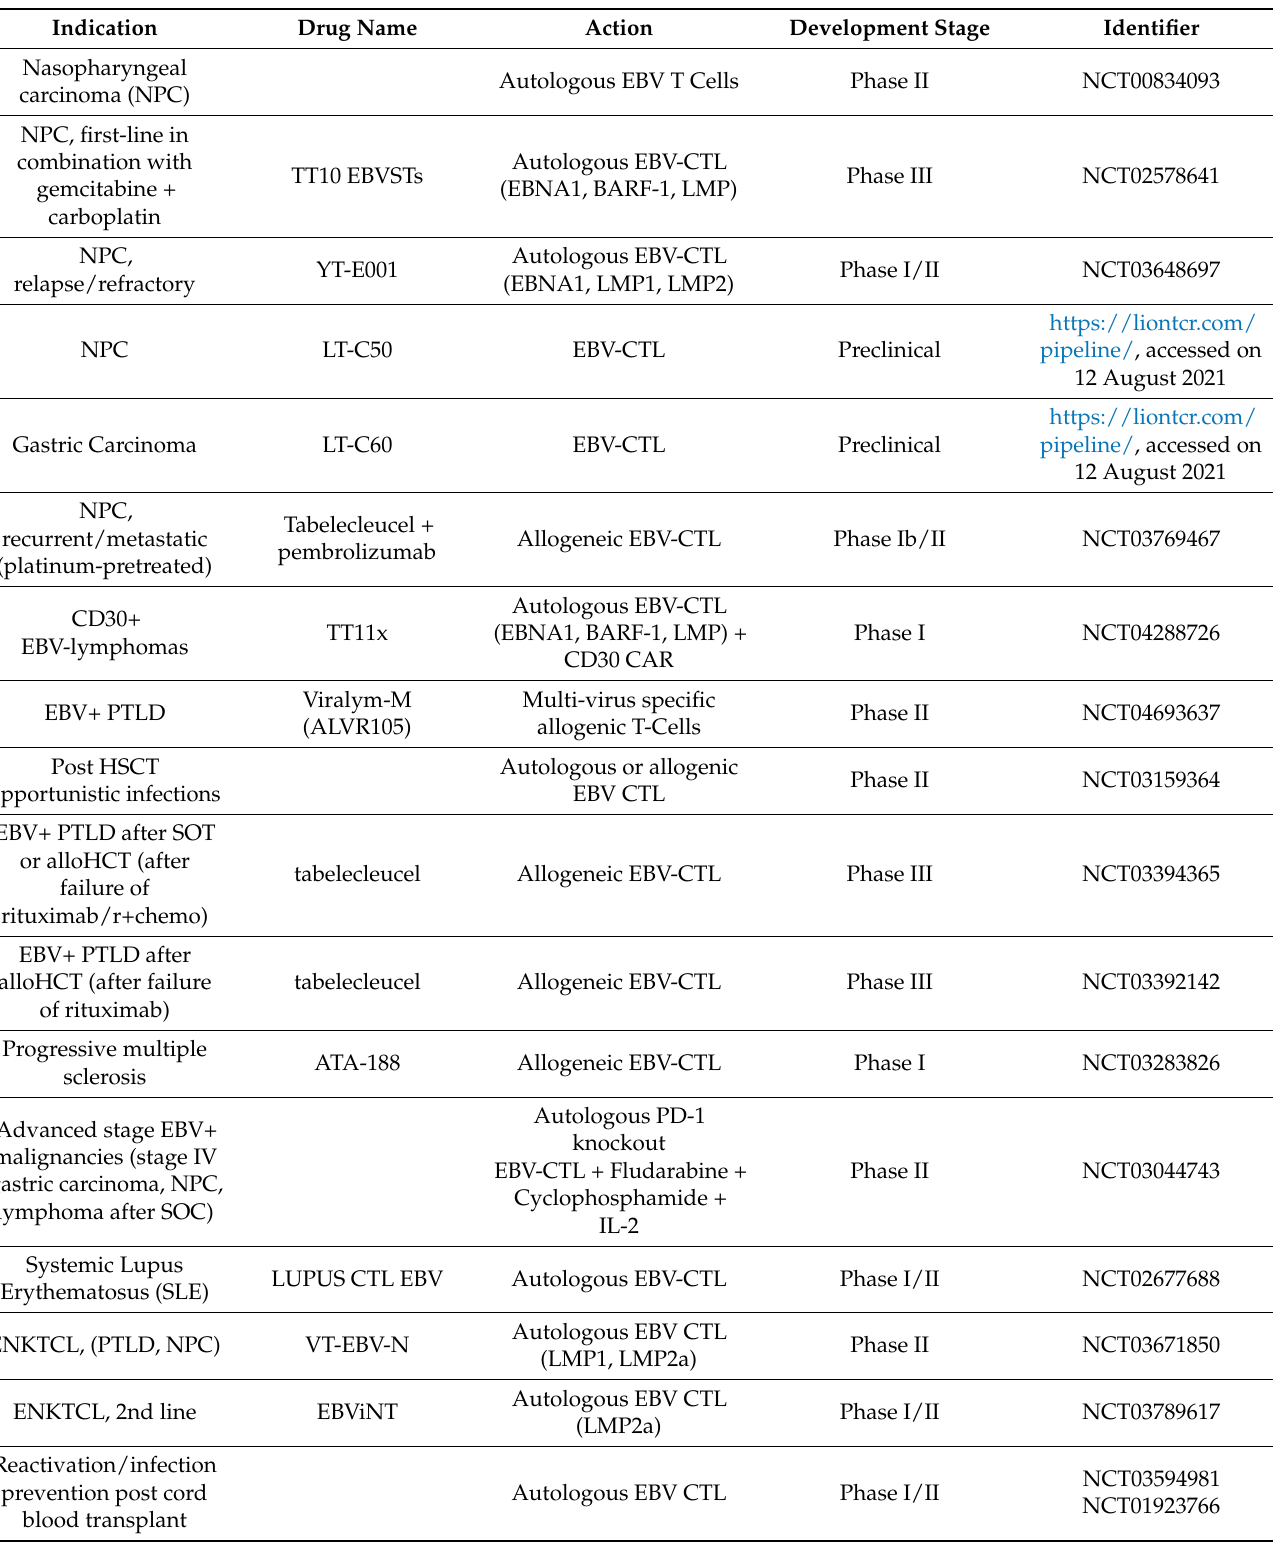
Table 5. Cellular immunotherapy pipeline for EBV-linked